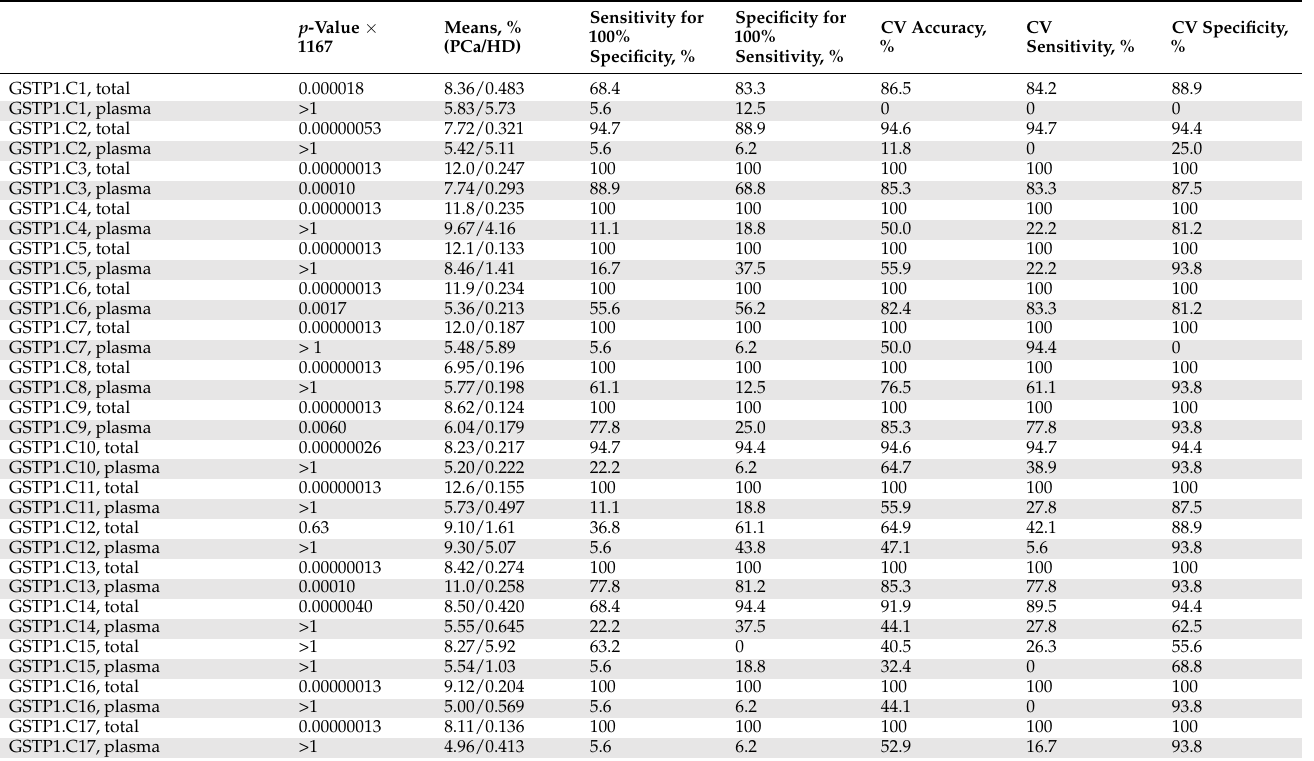
Table 4. Comparison of accuracies corresponding to the tcfDNA pool and cfDNA one for GSTP1